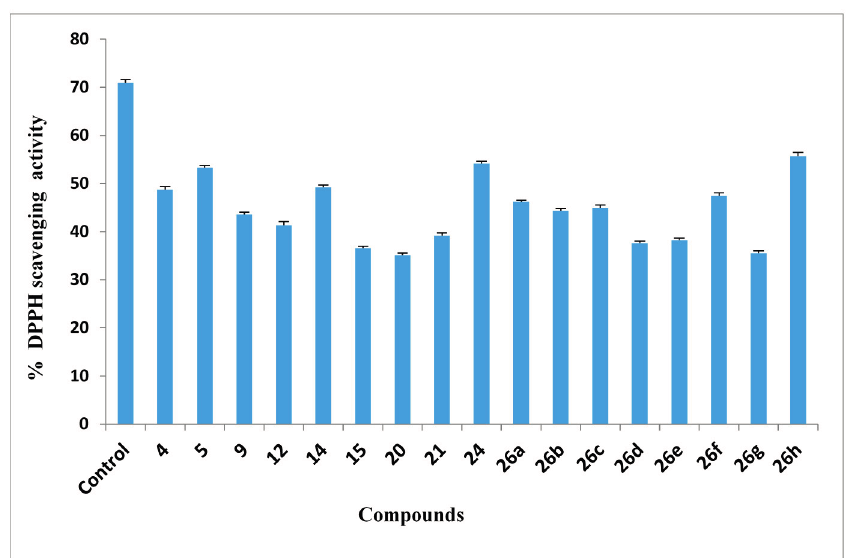
Figure 2. Antioxidant activities of compounds using DPPH.